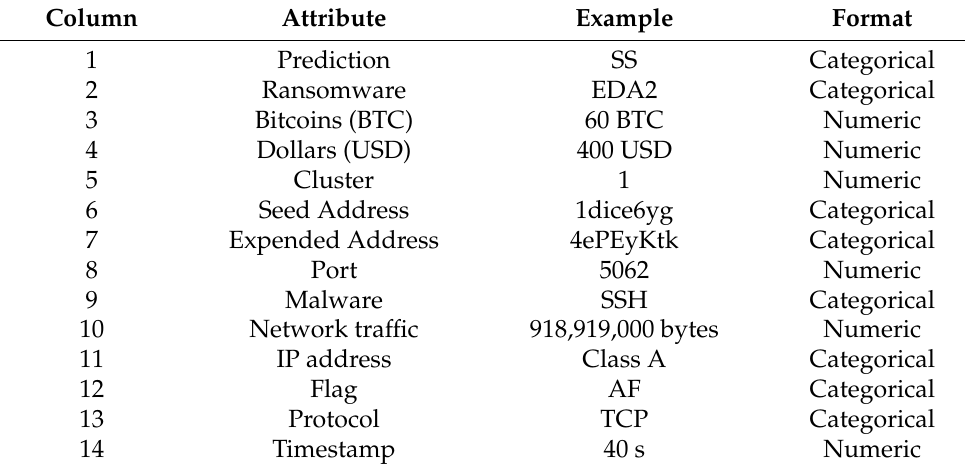
Figure 18. The nine phases followed during the UGRansome construction process. Data collection, feature extraction, feature selection, fuzzy merging, data pre-processing, prediction subdivision, data visualisation, Machine Learning, and evaluation. Table 7. The tabulate format of the final dataset with 14